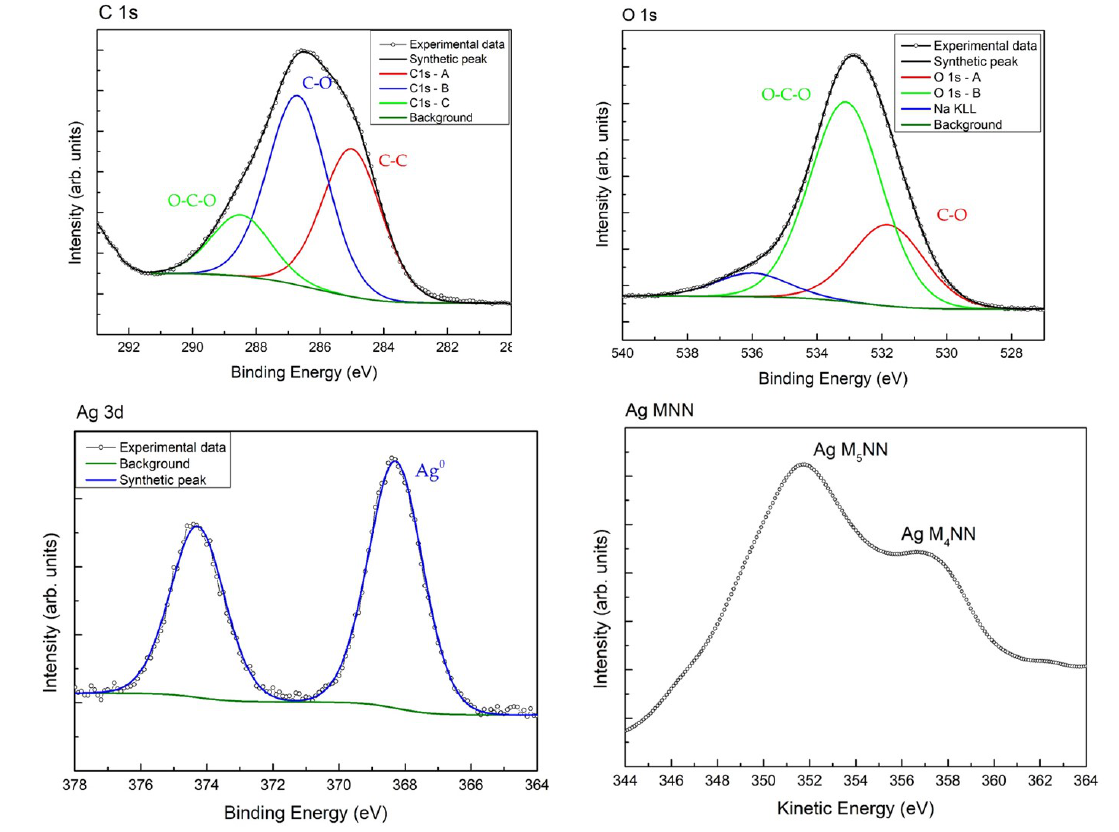
Figure 2. XPS spectra deconvolution for C 1s, O 1s, Ag 3d and Auger spectrum for Ag. The Ag 3d signal is characterized by the typical Ag 3d 5/2 –Ag 3d 3/2 doublet separated in energy by 6 eV. The Ag 3d 5/2 peak is positioned at BE = 368.2 eV, which could be as- signed to the presence of metallic silver. To better identify the silver oxidation state, the Auger parameter α′ was calculated given by the sum of the binding energy of the core